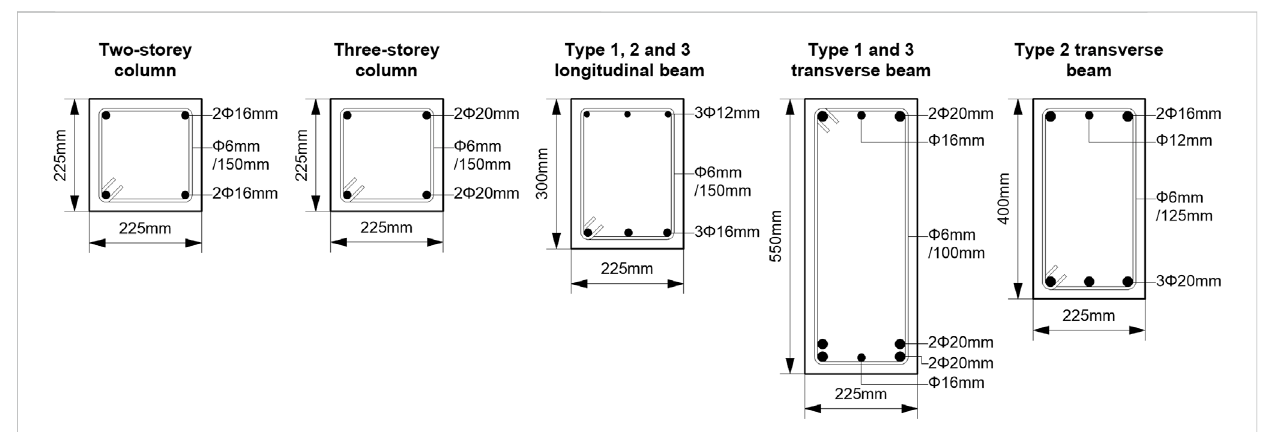
FIGURE 9 Typical column details for two- and three-storey school buildings (nominal